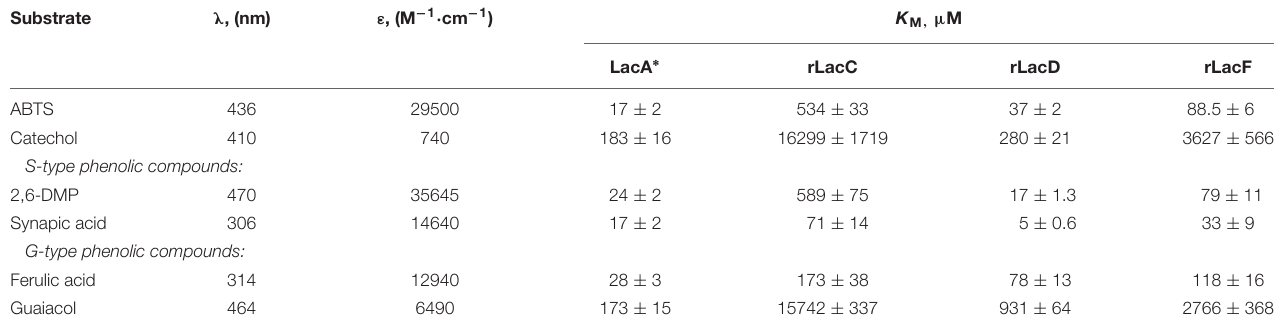
TABLE 1 | Kinetic constants ( K M ) of the laccase isozymes from T. hirsuta 072.